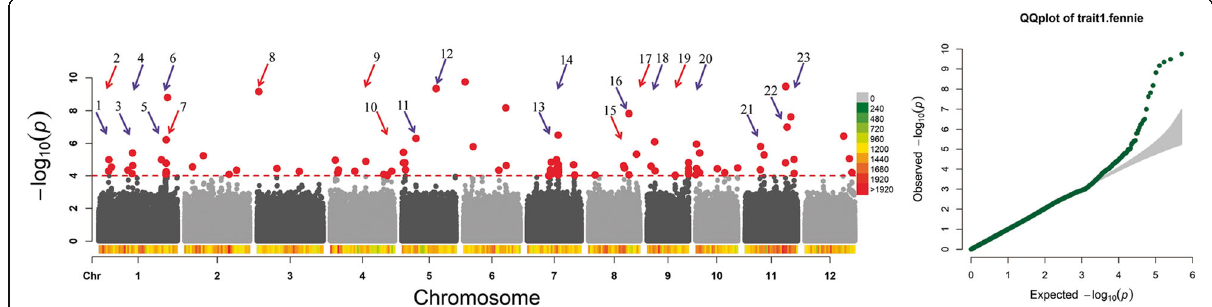
Fig. 2 GWAS of the TN variation using the S-RDP-II population and 700,000 SNP maps. X-axis represents 12 rice chromosomes and Y-axis represents the converted P-value ( − log 10 ( P ). Each red dot represents one SNP. Arrows represent the 23 LATNs: red arrows are LATNs co-localized with previously cloned TN associated genes, and blue arrows are the novel loci. Panel on the right is the correlated QQ plots